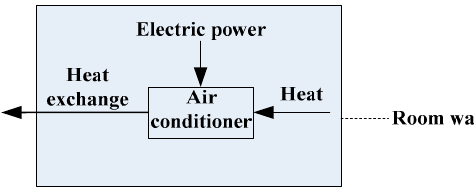
Figure 2. Heat exchange process for one air conditioner.